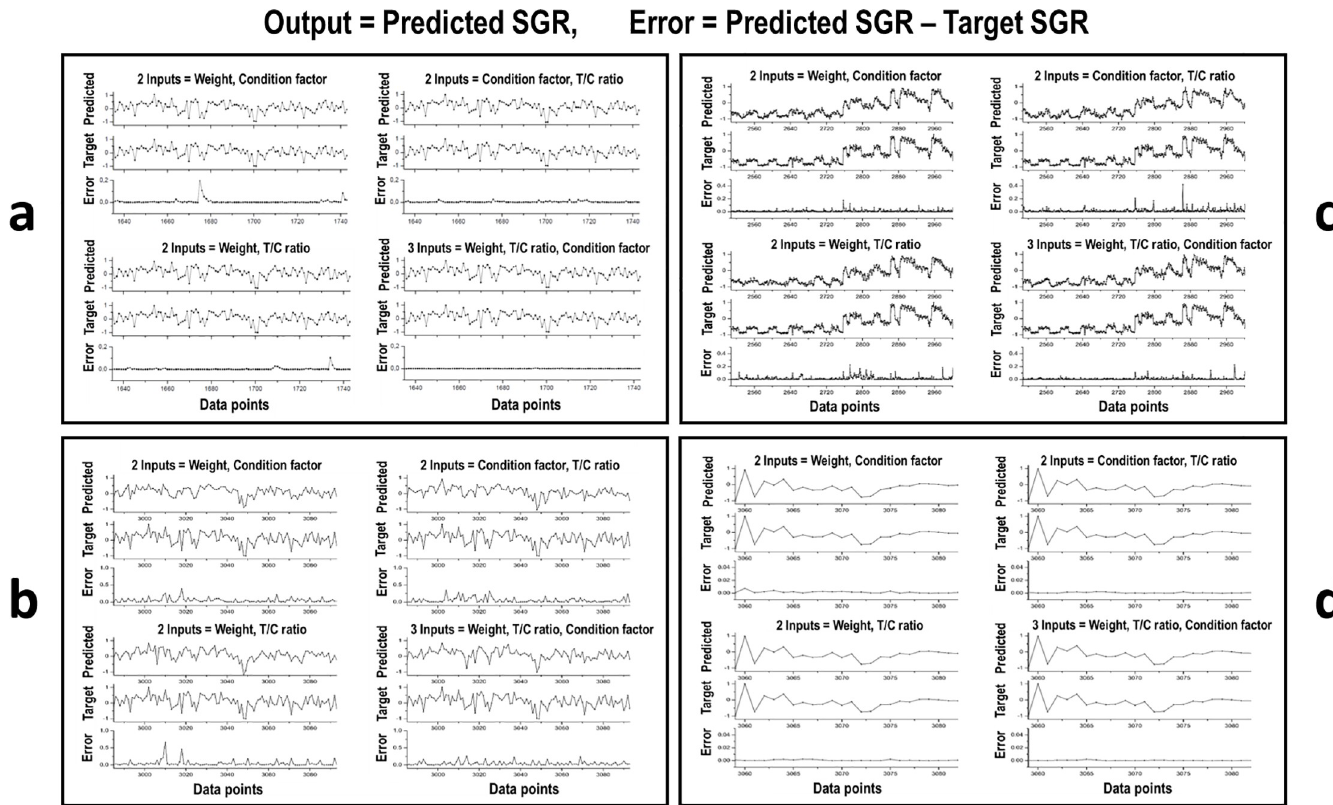
Fig 6. Comparison of predicted specific growth rate (SGR) outputs with the target normalized SGR using different input combinations. Different inputs to the reservoir-based neural network of our computational model were studied, using different reservoir network sizes of hidden neurons. The three-input combination of normalized weight, normalized pyloric caecal activity ratio of trypsin to chymotrypsin (T/C ratio), and normalized condition factor (CF) provided the best results of predicted SGR values with the lowest average error, compared to the two-input combinations. The importance of the T/C ratio input is also illustrated to provide less error in predicted SGR values. (a) Data4: Rainbow trout at adult stage during maturation (Fig 1D) using a large reservoir network size of 200 hidden neurons. The average errors in the three-input combination, and two-input combinations of the weight and T/C ratio, the T/C ratio and CF, and the weight and CF were 0.00047, 0.0038, 0.0039, and 0.0078, respectively. (b) Data4: Rainbow trout at adult stage during maturation (Fig 1D) using a reservoir network size of 50 hidden neurons. (c) Data1: Atlantic salmon at juvenile stage (Fig 1A) using a reservoir network size of 50 hidden neurons. (d) Data2: Atlantic salmon at post-smolt stage (Fig 1B) using a reservoir network size of 50 hidden neurons. For (b), (c), and (d), using 50 hidden neurons, the average errors in the three-input combination and two-input combinations are shown in Table 2.